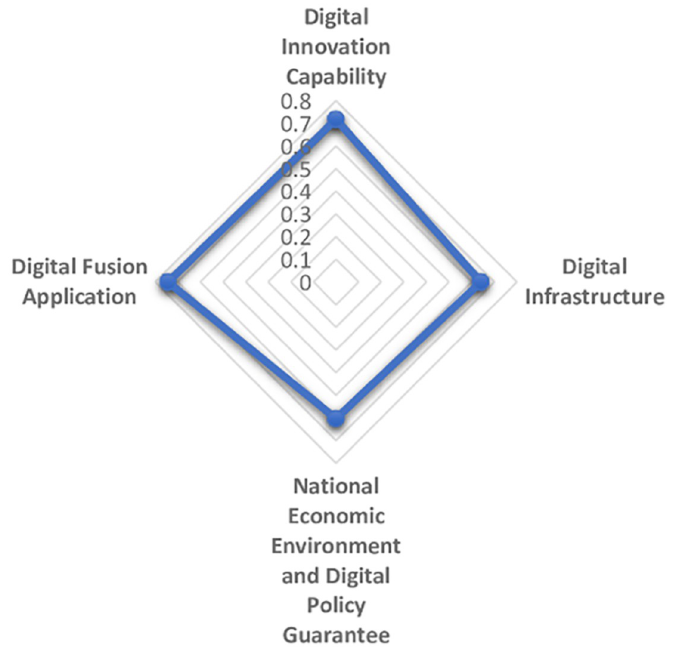
Fig 9. Radar map of western digital economy